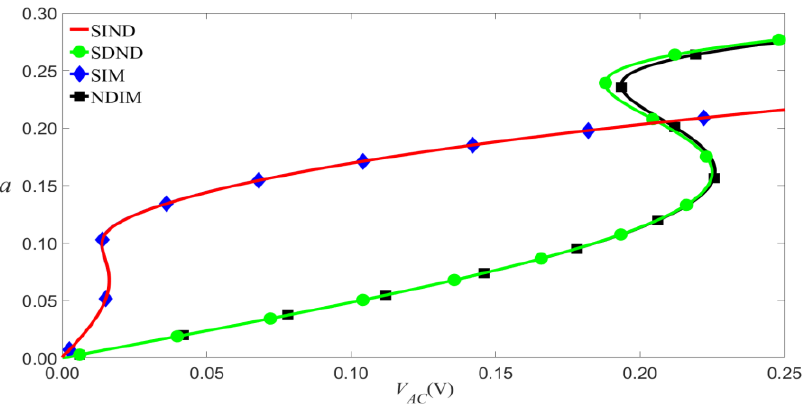
Figure 7. Amplitude of response as a function of the amplitudes of load’s for microbeam for V DC = 4 V, P 0 = 0.01 N, and σ =